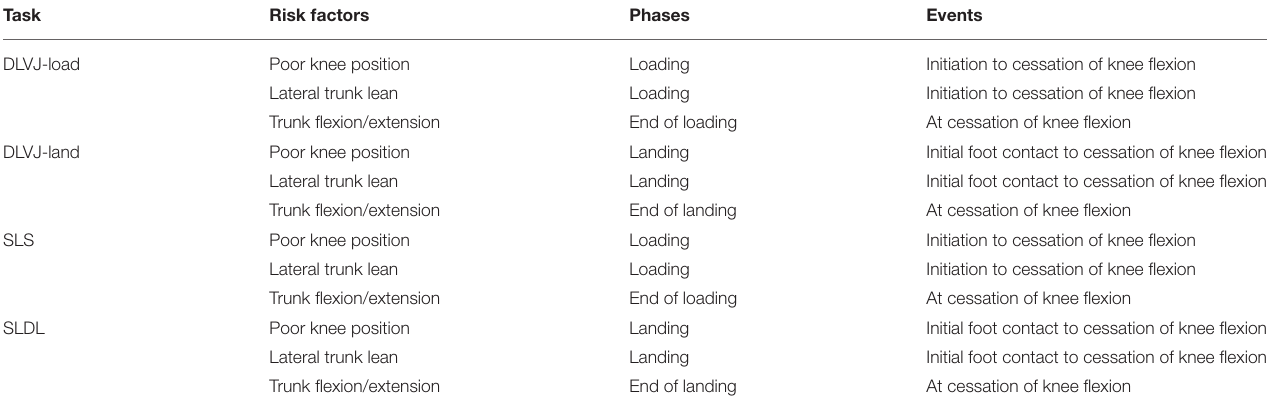
TABLE 1 | Phases of interest and event definitions for each task.